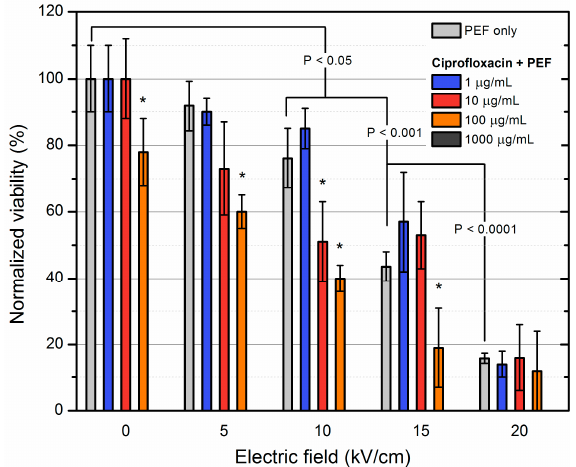
Figure 3. Inactivation of MRSA using electroporation separately and in combination with ciprofloxacin of varied concentration. Asterisk (*) represents statistically significant ( p < 0.05) difference versus PEF only treatment. Additive effect of PEF with antibiotic was observed at 5 kV/cm already indicating interaction of the antibiotic and permeabilized cell membrane.